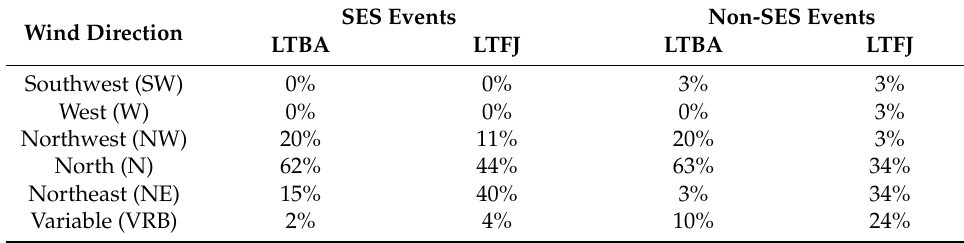
Table 2. The wind direction frequencies in SES and non-SES events at LTBA and LTFJ. Wind Direction